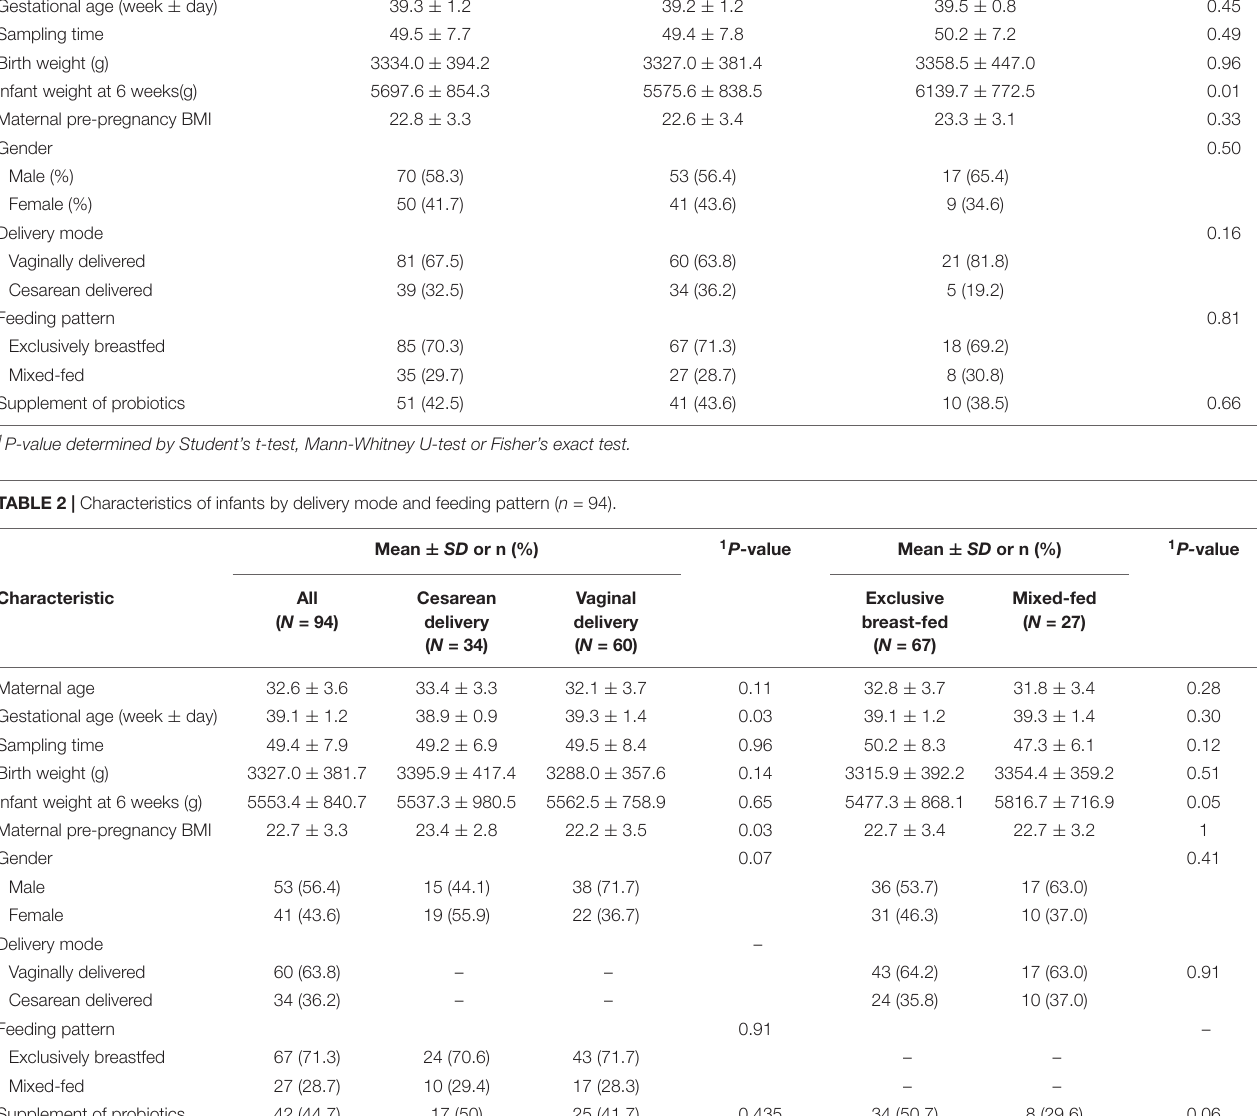
R 2 = 0.008, P = 0.6) or unweighted UniFrac analysis ( Supplementary Figure S2 , Adonis, R 2 = 0.016, P = 0.15). The LEfSe analysis found that mixed-fed infants harbored more class Negativicutes, order Selenomonadales, families Veillonellaceae and Enterococcaceae and genera Veillonella and Enterococcus , compared with the exclusively breastfed infants ( Figure 2C